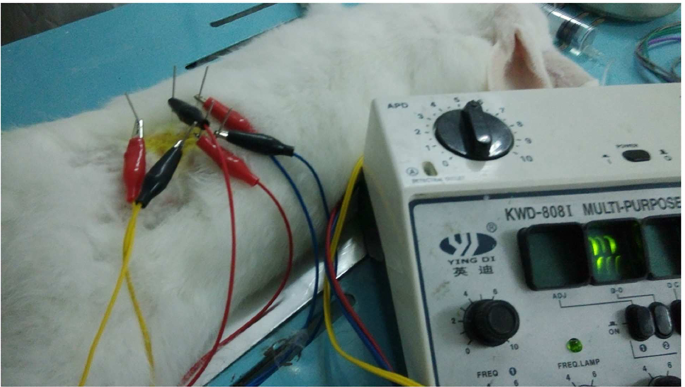
acupoint to a depth of 10-15mm. Then the needleswere connectedto a 3Hz/s electrical current.